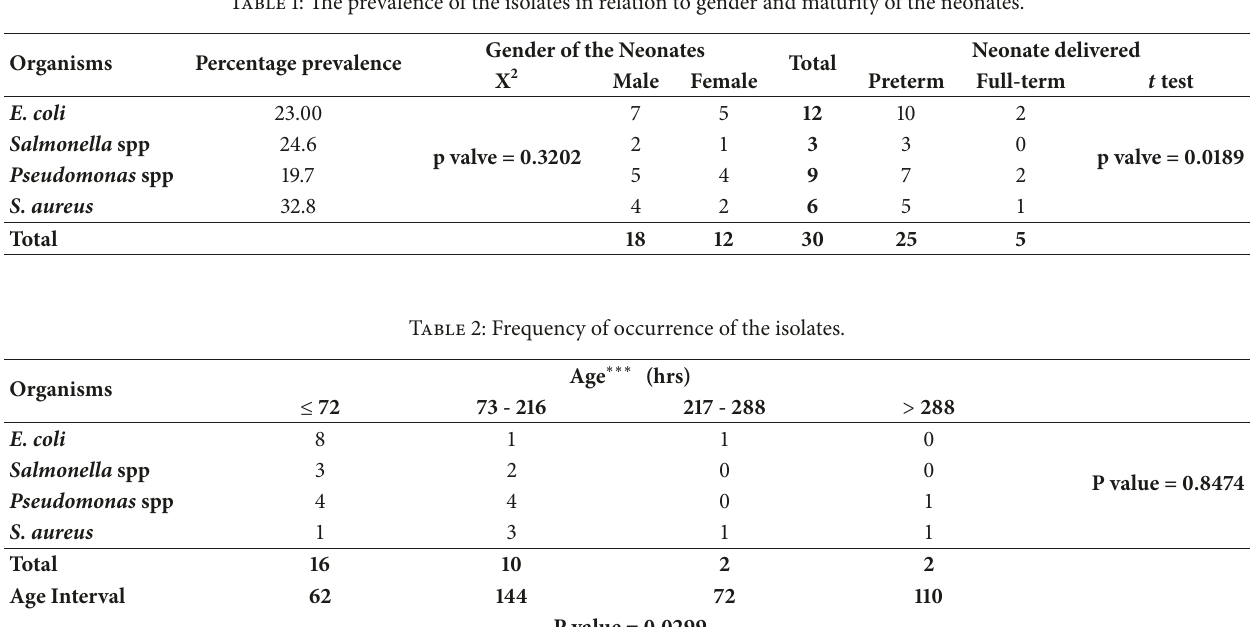
Table 1: The prevalence of the isolates in relation to gender and maturity of the neonates.